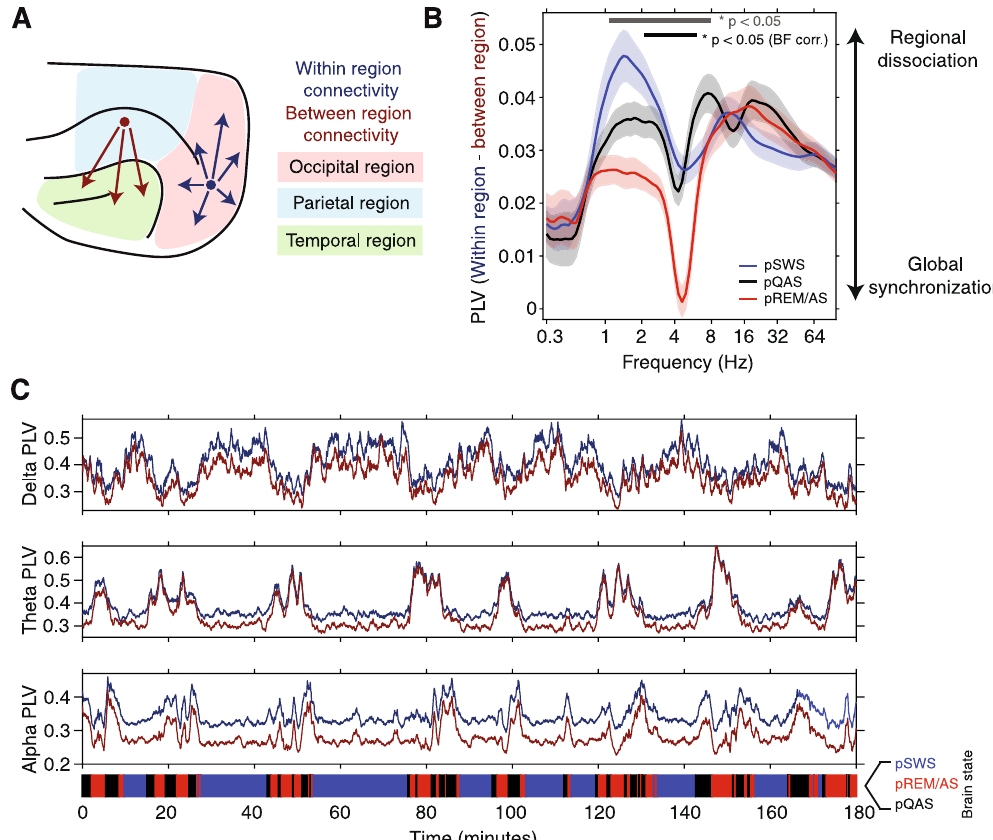
Figure 8. Comparison of short-range within-region, and long-range between-region functional connectivity. ( A ) µ ECoG electrodes were grouped into either occipital (red), parietal (blue), or temporal (green) regions based on the cortical area that was underlying each electrode. PLV was then computed for pairs of electrodes that fell within the same group (dark blue arrows) and pairs of electrodes that were between groups (red arrows). ( B ) Difference between within-region and between-region PLV, plotted as a function of carrier frequency. Large values of PLV (within – between region) suggest that short-range connections dominate over long-range connections, indicating a dissociation of cortical regions. While small values of PLV (within – between region) indicate that the strength of short-range and long-range connections is similar, inferring that the cortex is in a state of global synchronization. Note that long-range cortical synchronization is maximally fragmented during the pSWS state at the delta carrier frequency. In contrast, globally synchronized theta oscillations can be observed during the pREM/AS state. Significant state-dependent modulation of PLV (within – between region) is shown as bars at the bottom of the plot (gray bar – no correction for multiple comparisons p < 0.05, black bar – Bonferroni corrected p < 0.05, n = 80 frequencies). ( C ) Strength of within-region PLV (dark blue) and between-region PLV (red), computed using a one-minute sliding window across an example recording from animal #2. The result of objective brain state classification is shown as a color bar at the bottom of the plot (pSWS – blue, pREM/ AS – red, pQAS – black). State transitions lead to marked changes in patterns of local and long-range cortical synchronization. Note how within-region and between-region theta PLV traces converge and diverge as animals enter and exit the pREM/AS (middle